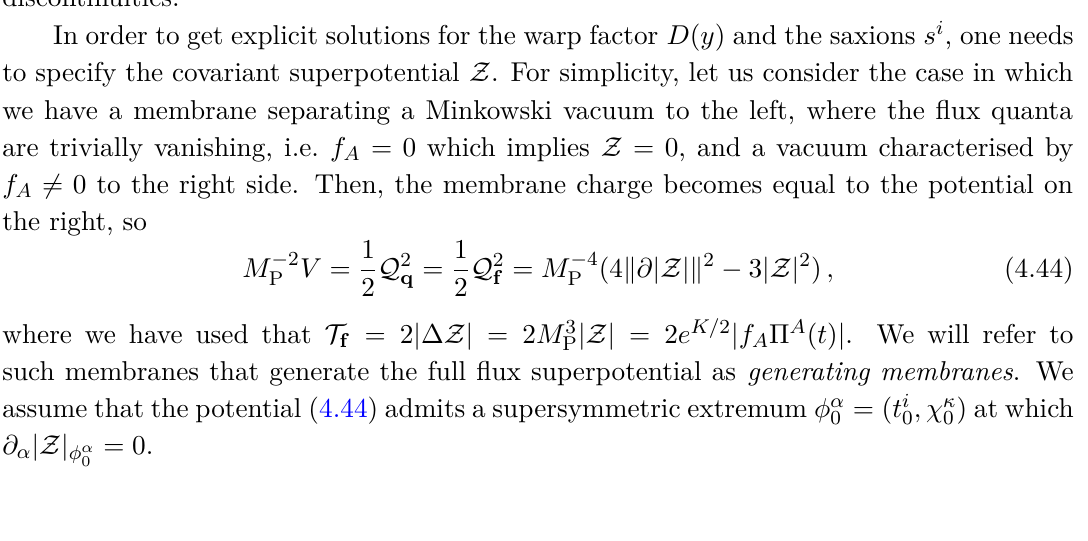
Q 2 for the f 2